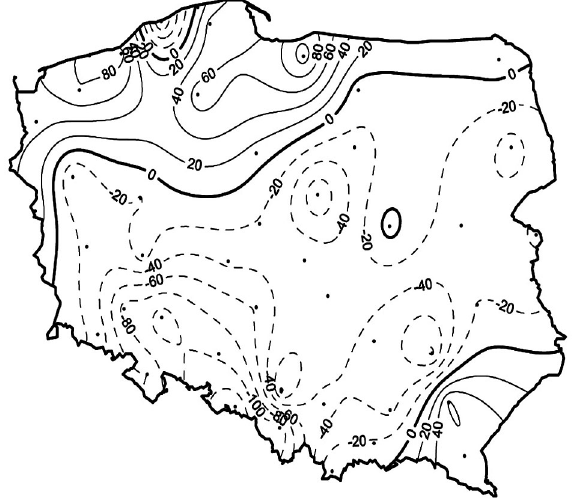
Fig. 11. Changes in annual precipitation totals in Poland (mm/48 yrs) in the years 1961–2008 (after Marosz et al.